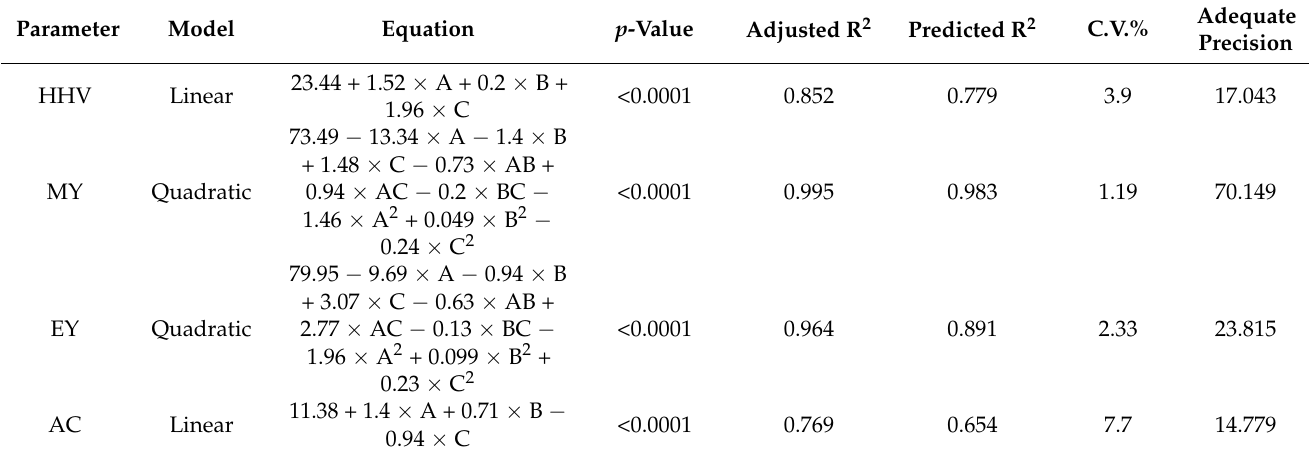
Table 3. Fitted model and equations generated by RSM software and statistics for each